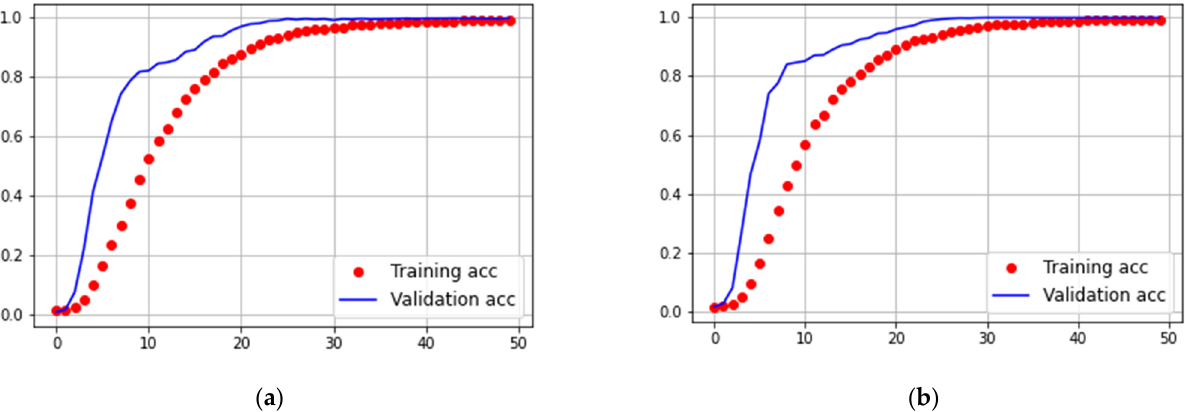
Figure 11. Sample training and validation curves of the CNN mapping operation. ( a ) Grayscale operation. ( b ) Binarization operation.